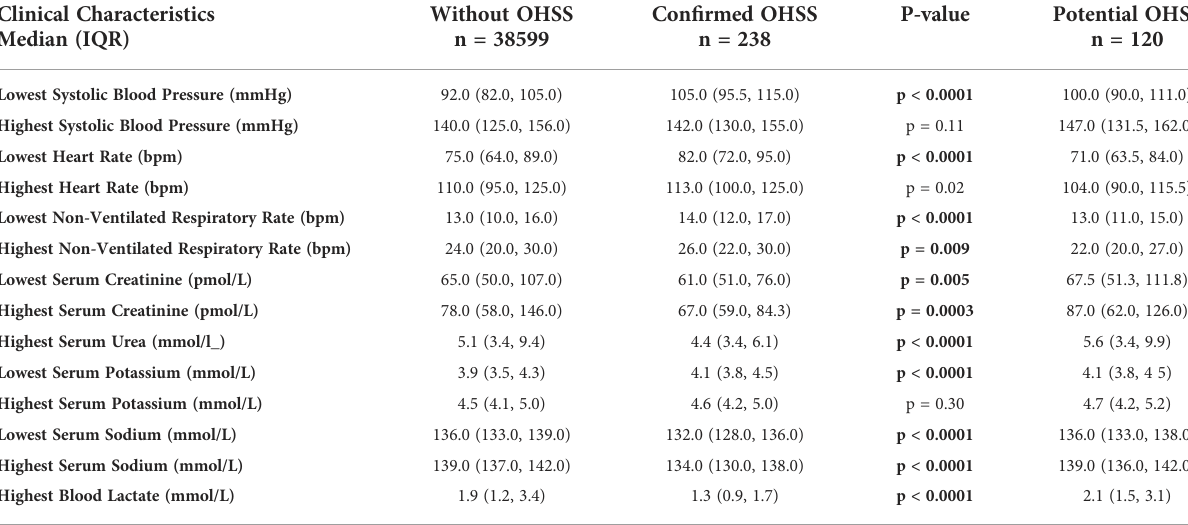
TABLE 2 Laboratory and clinical fi ndings of patients requested from ICNARC, 1996-2020. Clinical